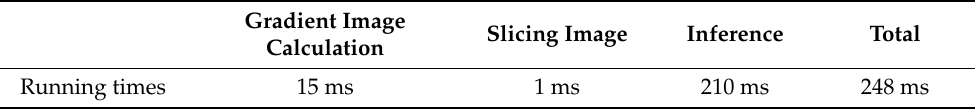
Table 3. The average calculation time of predicting the quality of one fecal microscopic